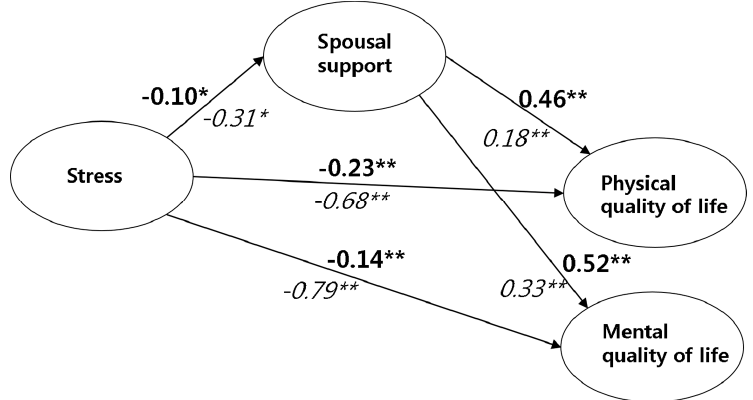
Figure 2. Moderating e ff ects of American Cancer Society nutrition and physical activity guidelines for cancer survivors (ACS guideline) adherence on spousal support in the relationship between stress and health-related quality of life ( β ); * p < 0.050; ** p < 0.010; Bold : standardized estimated β coe ffi cient of the high ACS guideline adherence group; Italic : standardized estimated β coe ffi cient of the low ACS guideline adherence